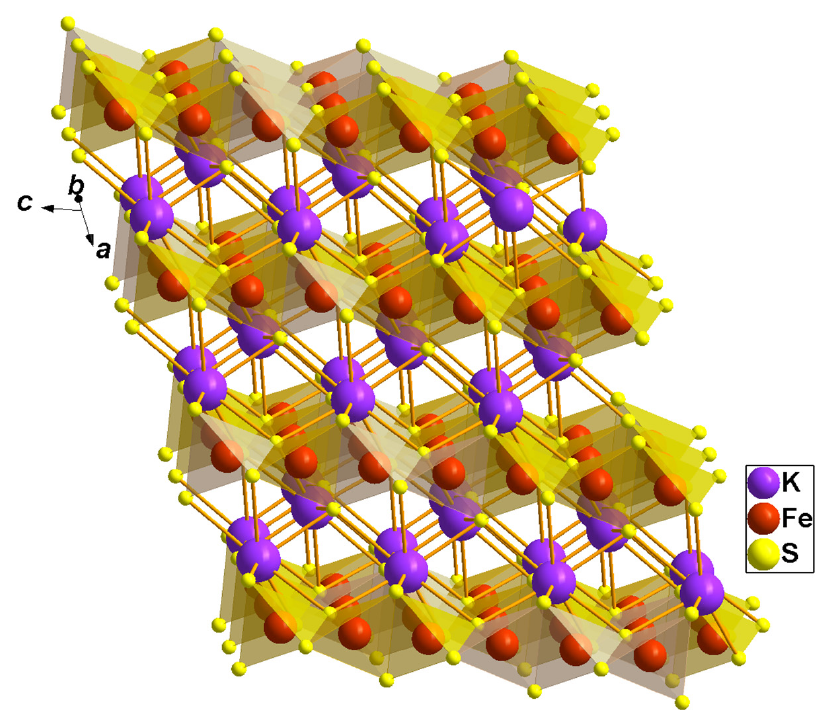
Figure 1. Crystal structure of KFeS 2 . The FeS 4 tetrahedra, with Fe drawn as a red sphere in the center and S as a yellow sphere at the corners and highlighted in a transparent orange color. Violet large spheres denote K.